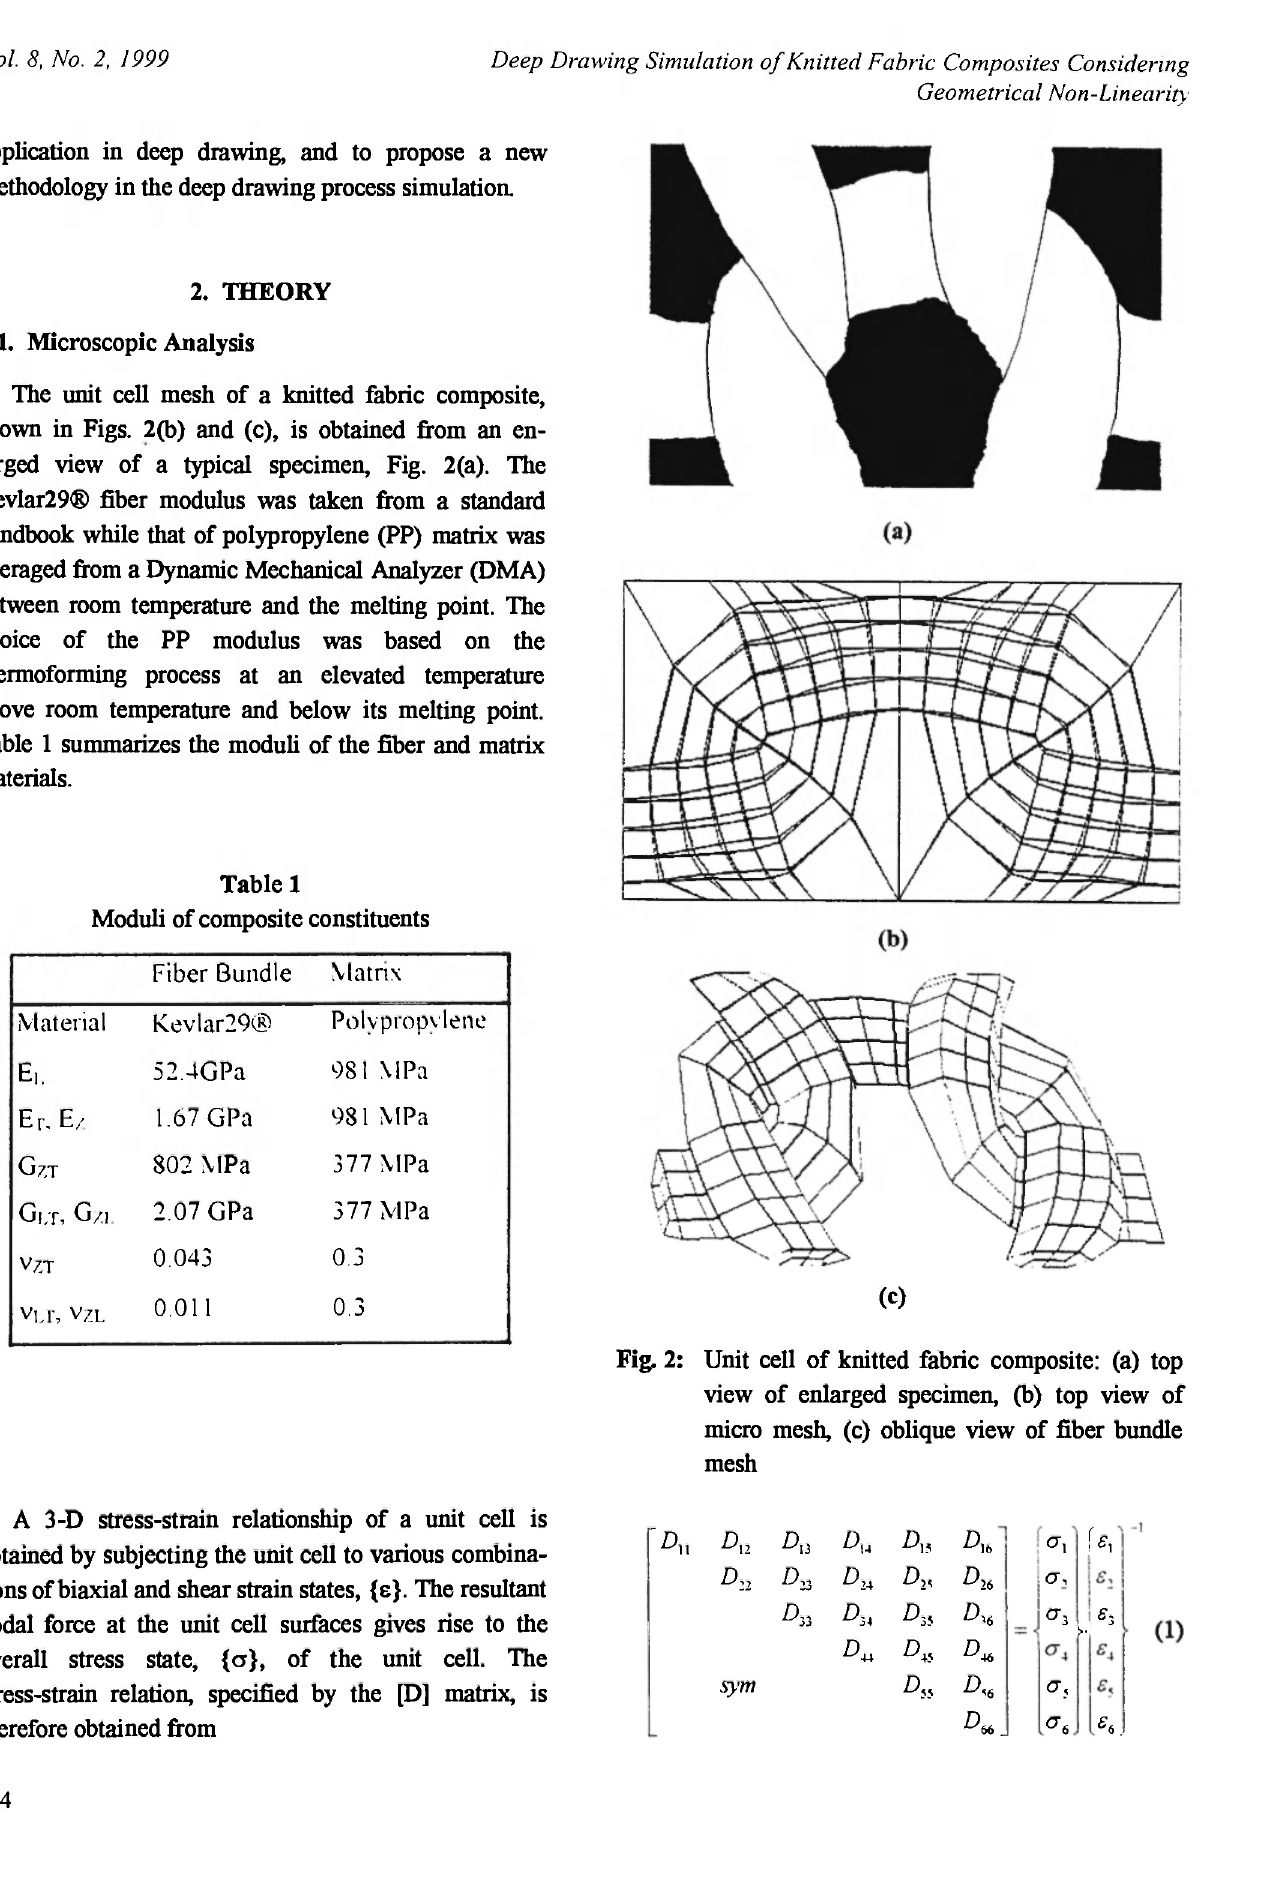
Fig. 2: Unit cell of knitted fabric composite: (a) top view of enlarged specimen, (b) top view of micro mesh, (c) oblique view of fiber